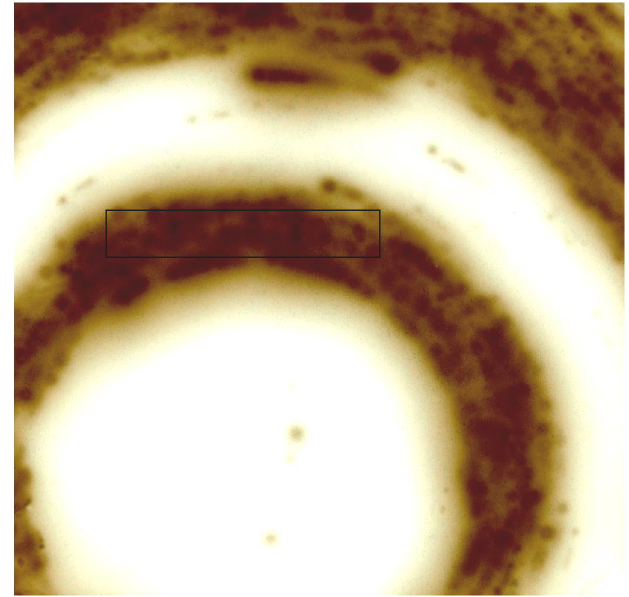
FIG. 6. (Color) The pattern of dark current radiation damage on a glass slide at the exit window of an open-cell rf cavity. These data are described in Ref. [1]. The area used for the analysis of optical density is shown in the (cid:4) (cid:1) (cid:7) in a way that shows the This figure plots the function s 3 discontinuity at (cid:1) as a change of slope. The optical eq density measured for the photograph in Fig. 6, shown in an inset, is fitted with a curve, and points from this curve are compared with the expected spectrum of dark current